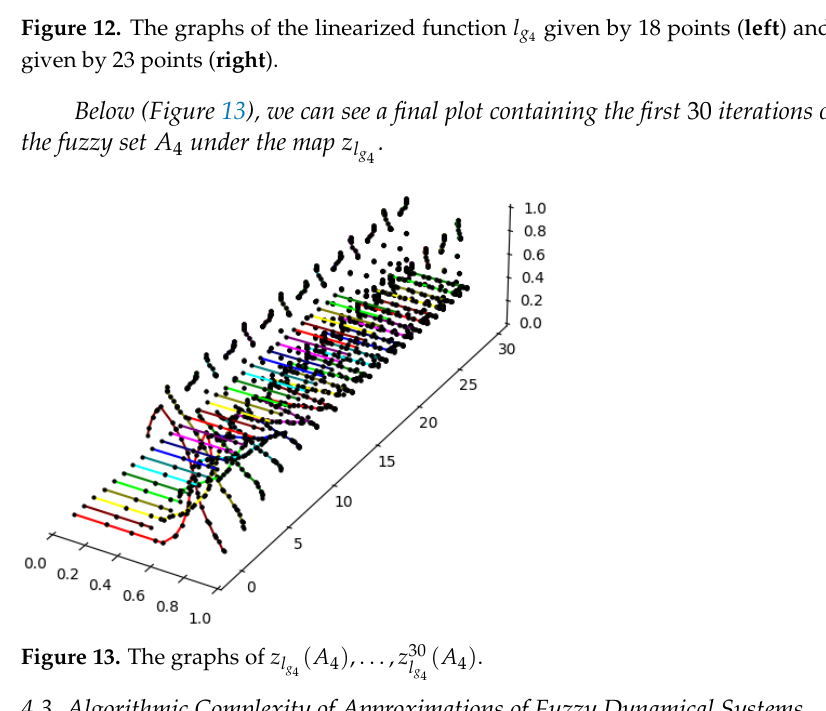
Figure 13. The graphs of z l